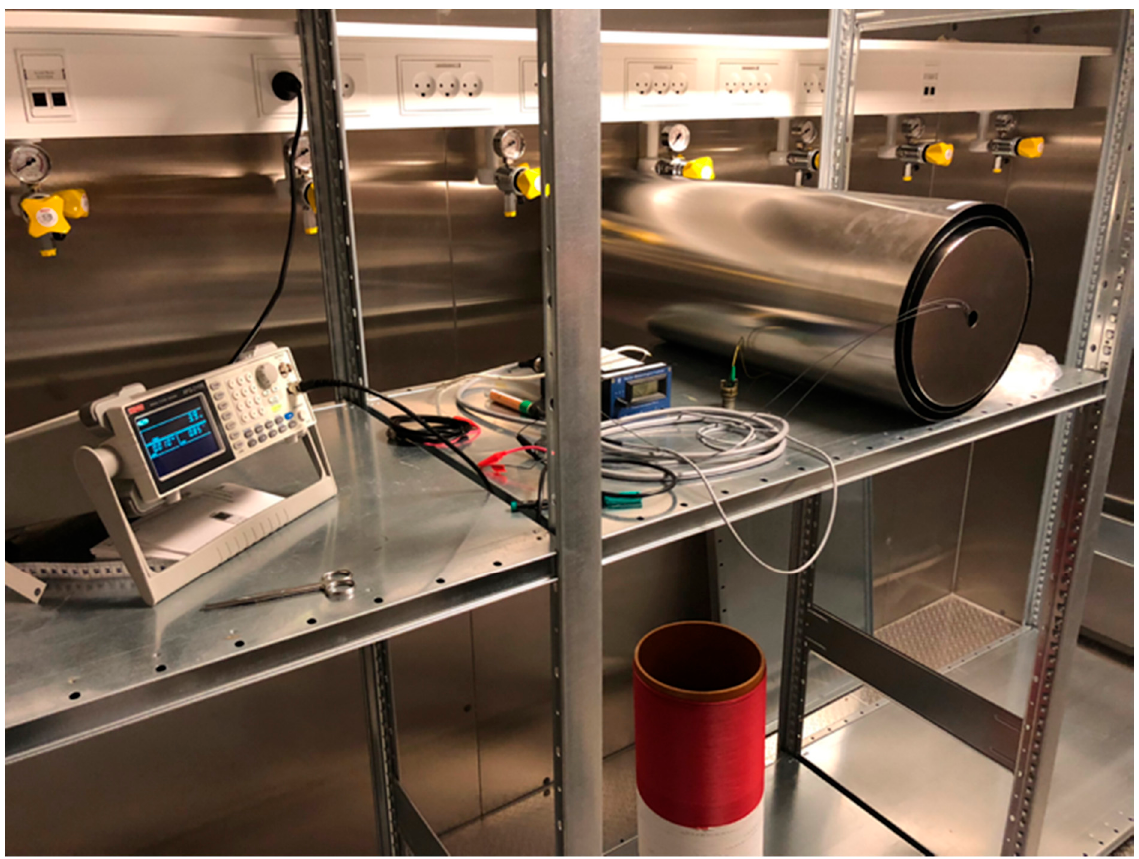
Figure 1. The bioresonance lab is temperature-controlled at 37 °C and includes a function generator (left), a magnetometer (center), a triple-layer amagnetic mu-metal cylinder (right), and a custom-made solenoid (red/white, bottom) that fits inside the mu-metal cylinder.